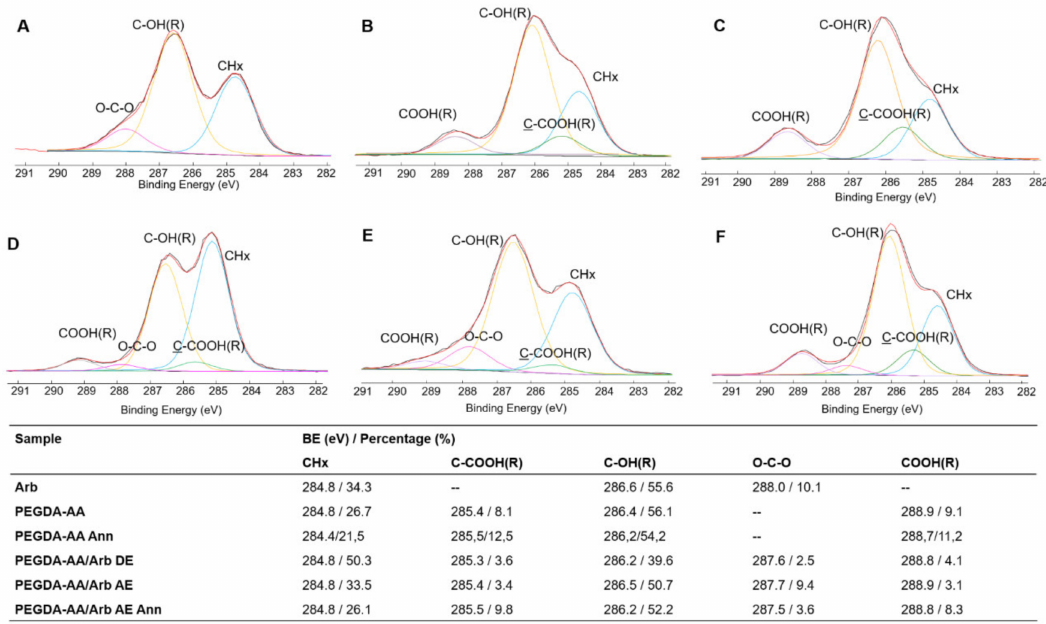
Figure 5. Curve fitting of C1s signals of ( A ) pure arbutin and ( B ) PEGDA-AA, ( C ) PEGDA-AA Ann., ( D ) PEGDA-AA / Arb DE, ( E ) PEGDA-AA / Arb AE and PEGDA-AA / Arb AE Ann. ( F ) Coatings electrosynthesized on Ti sheets. Attributions, binding energies values and percentages are reported in the